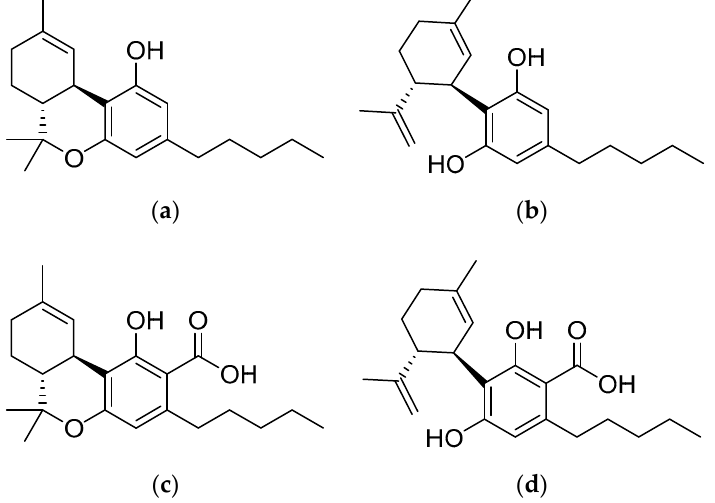
Figure 1. Major phytocannabinoids present in C. sativa : ( a ) Δ 9 -tetrahydrocannabinol, ( b ) cannabidiol, ( c ) Δ 9 -tetrahydrocannabinolic acid, and ( d ) cannabidiolic acid.